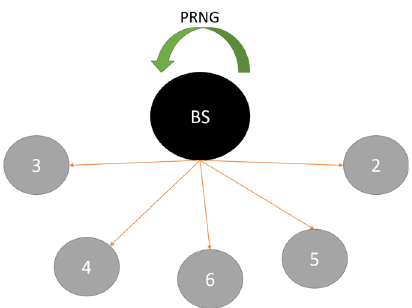
Figure 5. Pre-Deployment process: The access points receiving their respective unique random numbers from the BS.